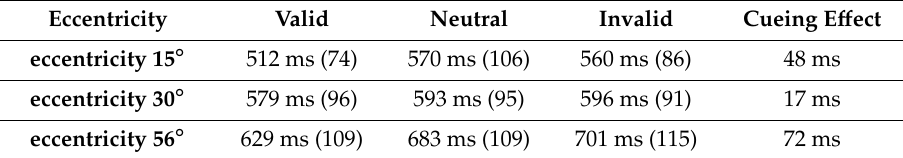
Table 1. It shows the mean and standard deviations for Cueing ×